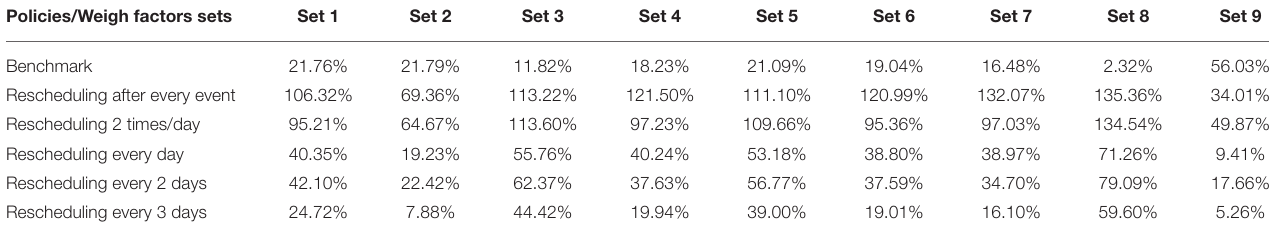
TABLE 5 | Relative difference from the events management